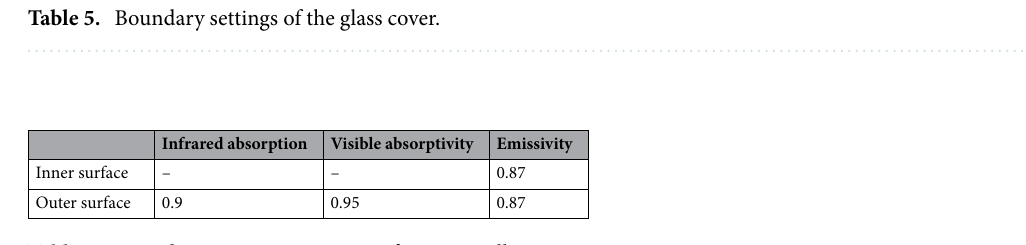
Table 6. Boundary parameters setting of porous wall.